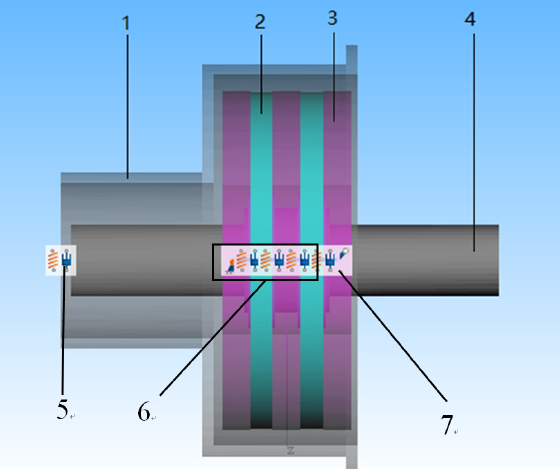
Figure 6. The Simpack dynamics model of friction clutch. (1) Clutch housing (2) Moving plate (3) Static plate (4) Input shaft (5) Fixed constraints (6) Friction pair restraint (7) Drive constraints.